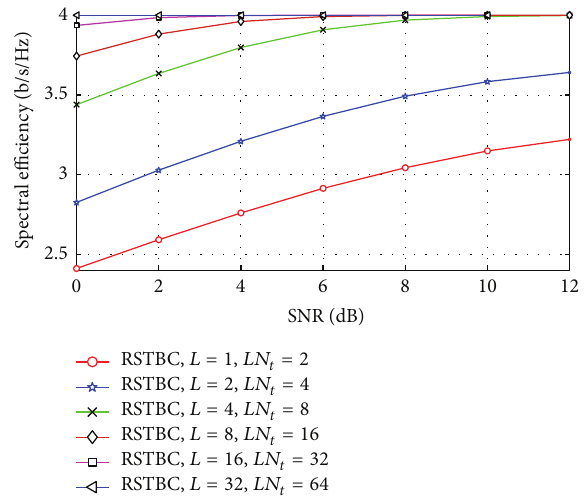
Figure 6: Spectral efficiency of RSTBC with ( 𝐿 = 1, 2, 4, and 8) for MIMO system with QPSK and 25%-loss rate ( 𝑁 𝑡 = 2 , 𝑁 𝑟 = 2 , 𝑇 = 2 ).